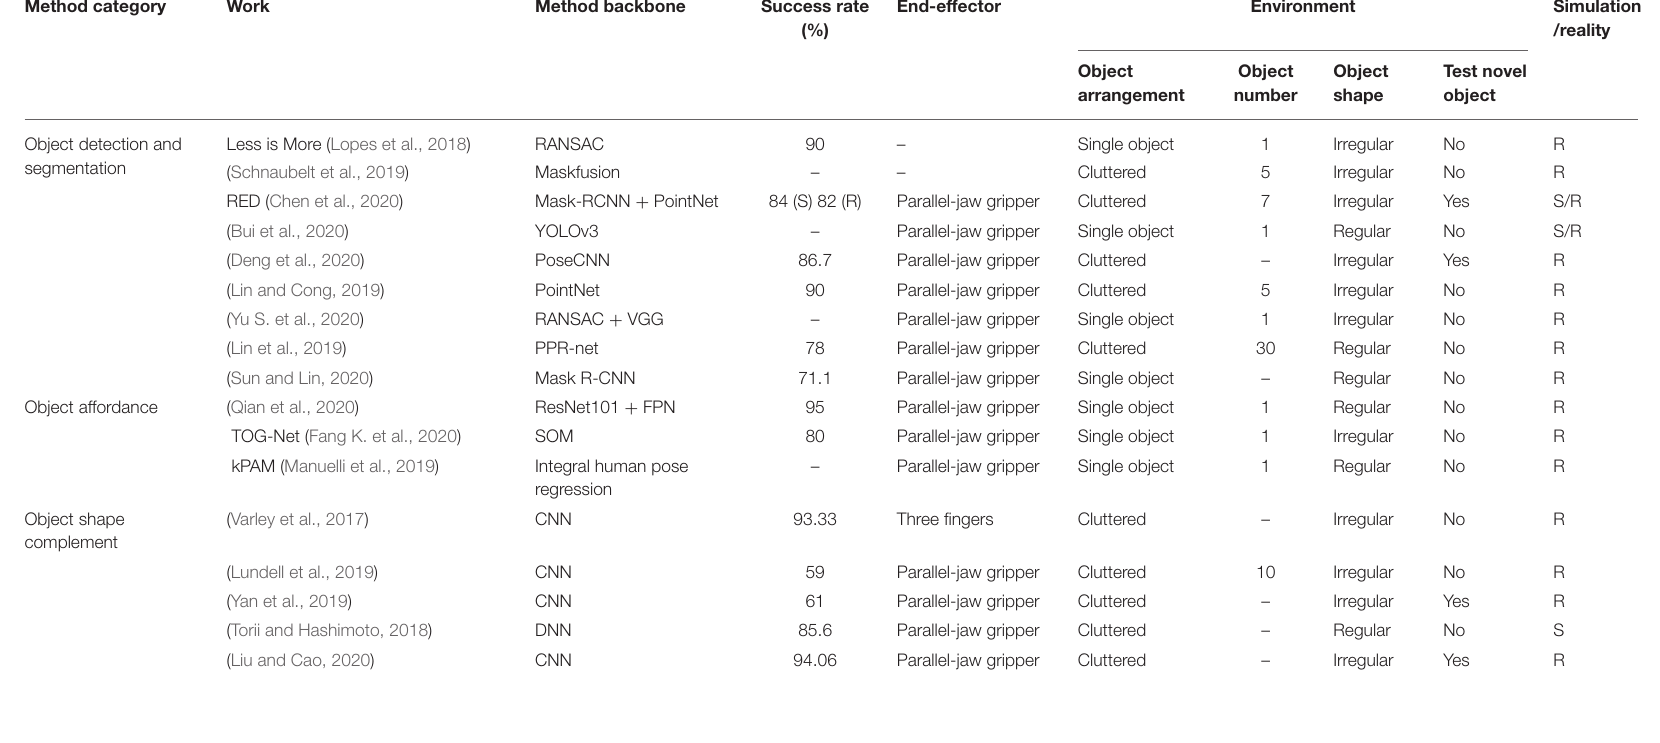
TABLE 2 | The summary of geometry-base object-aware grasp candidate generation. Method